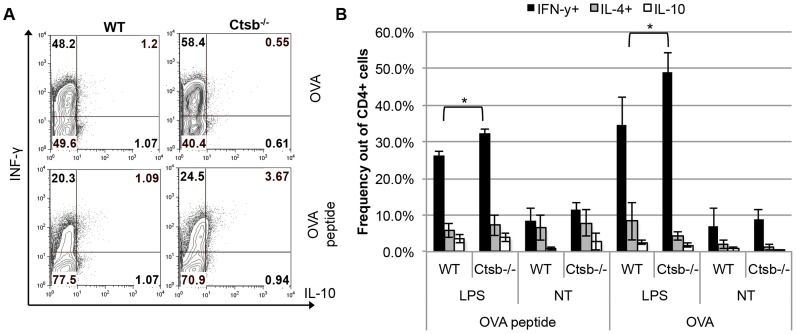
Th1 polarization of OT-II CD4+ naïve T cells by BMDC from WT C57BL/6 and Ctsb−/− mice.Isolated CD4+ CD25− T cells from OT-II mice were co-cultured with BMDC generated from WT C57BL/6 and Ctsb−/− mice in the presence of LPS as a stimulus and OVA peptide (327–339) or ovalbumin (OVA) as antigens. A) Zebra plots from one representative experiment. B) Average percentages of IFN-γ, IL-4, or IL-10+ CD4+ T cells from 3 independent experiments ± SD. * p<0.05.